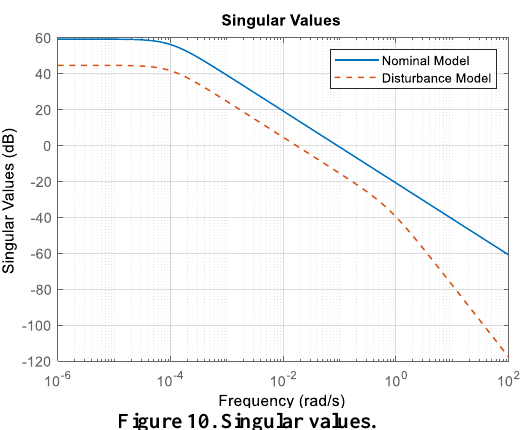
Figure 10. Singular values.